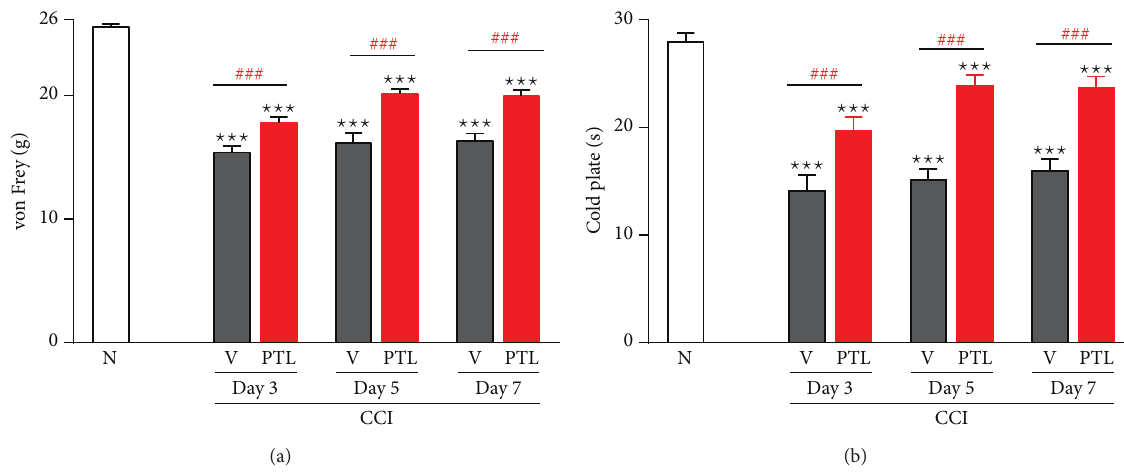
Figure 1: The effect of PTL on allodynia (von Frey test) and hyperalgesia (cold plate test) in CCI-exposed rats. Na¨ıve rats do not show symptoms of neuropathy ((a) and (b)). In CCI-exposed rats, PTL (5 𝜇 g/5 𝜇 L) and vehicle were i.t. administered preemptively 16h and 1h before CCI and once daily over 7 days. The response to PTL was measured 30 minutes after administration by the von Frey test (a) and 35 minutes after administration by the cold plate test (b) 1 day before CCI and then on days 3, 5, and 7 after injury. Repeated PTL administration diminished the development of neuropathic pain. PTL significantly reduced mechanical allodynia (a) and thermal hyperalgesia (b) on days 3, 5, and 7 after CCI. The data are presented as the mean response ± SEM (10–20 rats per group). The results of the experiments were statistically evaluated using one-way analyses of variance (ANOVA). The differences between the treatment groups throughout the study were further analyzedwithBonferroni’sposthoctests. ∗∗∗ 𝑃 < 0.001 indicatesignificantdifferencescomparedtona¨ıverats. ### 𝑃 < 0.001 indicatesignificant differences between vehicle-treated and PTL-treated CCI-exposed rats. N-na¨ıve, V-vehicle, and